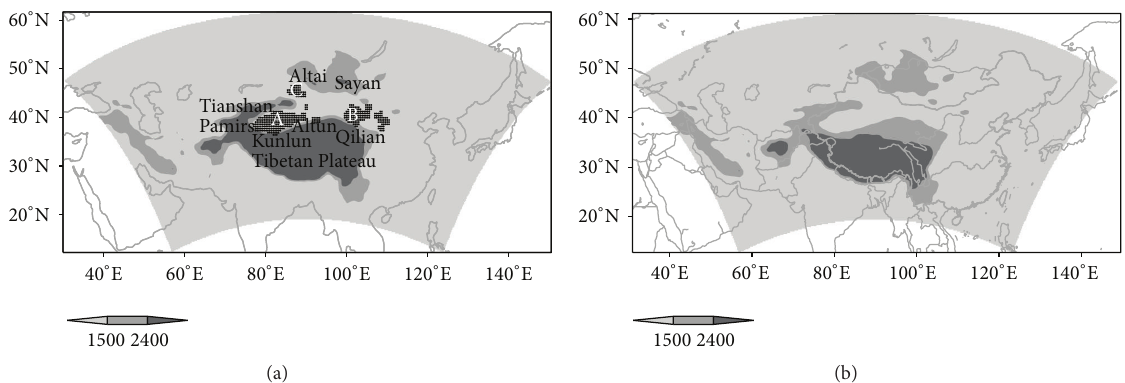
Figure 1: (a) Modern terrain used in HMD and HM and the locations of the major mountain ranges. The dotted areas indicate the three major deserts in China. A = southern Xinjiang in the Taklamakan desert; B = western Inner Mongolia in the Gobi desert; C = northern Xinjiang in the Gurbantunggut Desert. (b) Lowered terrain distribution used in LM and LMD. The lightest grey region in (a, b) is the model domain.